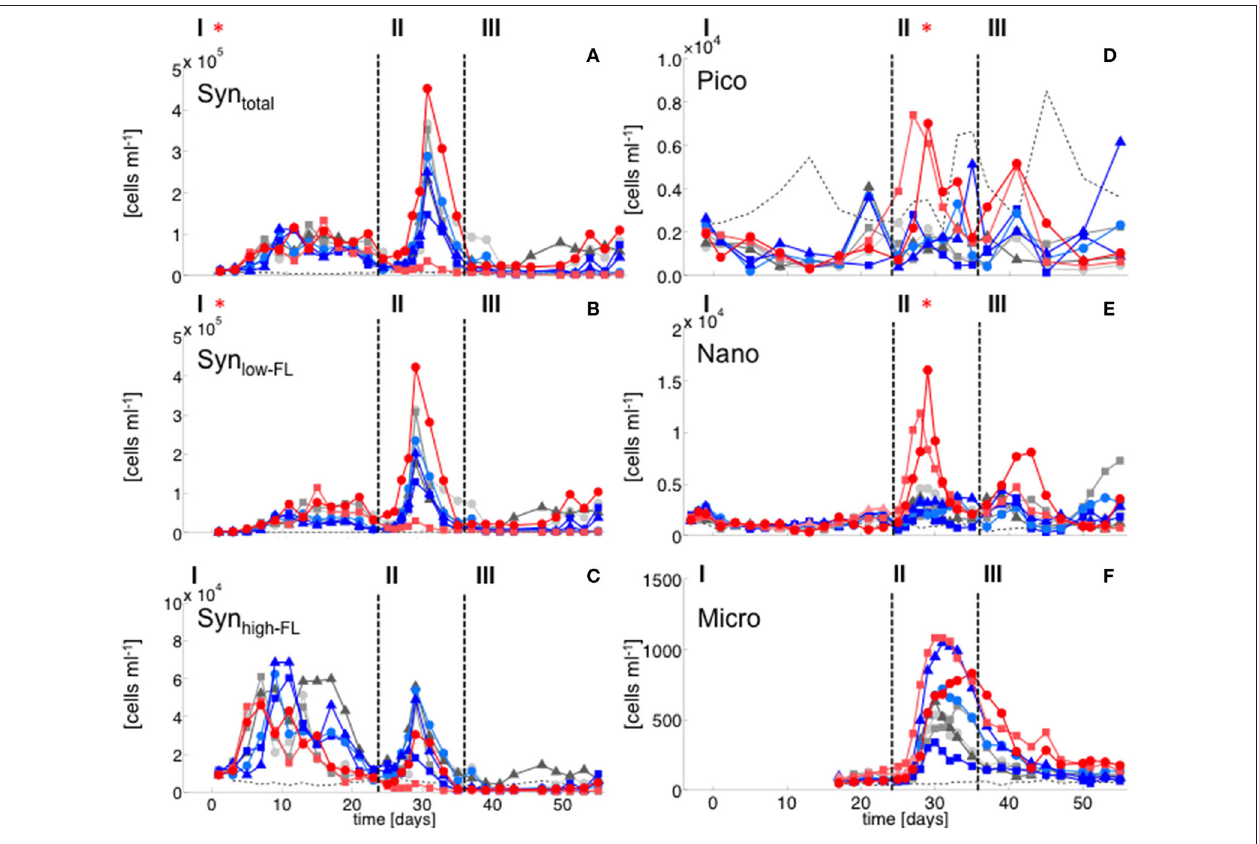
FIGURE 3 | Flow cytometry. (A) Synechococcus total, (B) Synechococcus low fluorescence cluster, (C) Synechococcus high fluorescence cluster, (D) Picoeukaryotes, (E) Nanophytoplankton, (F) Microphytoplankton. Color code and symbols as in Figure 2